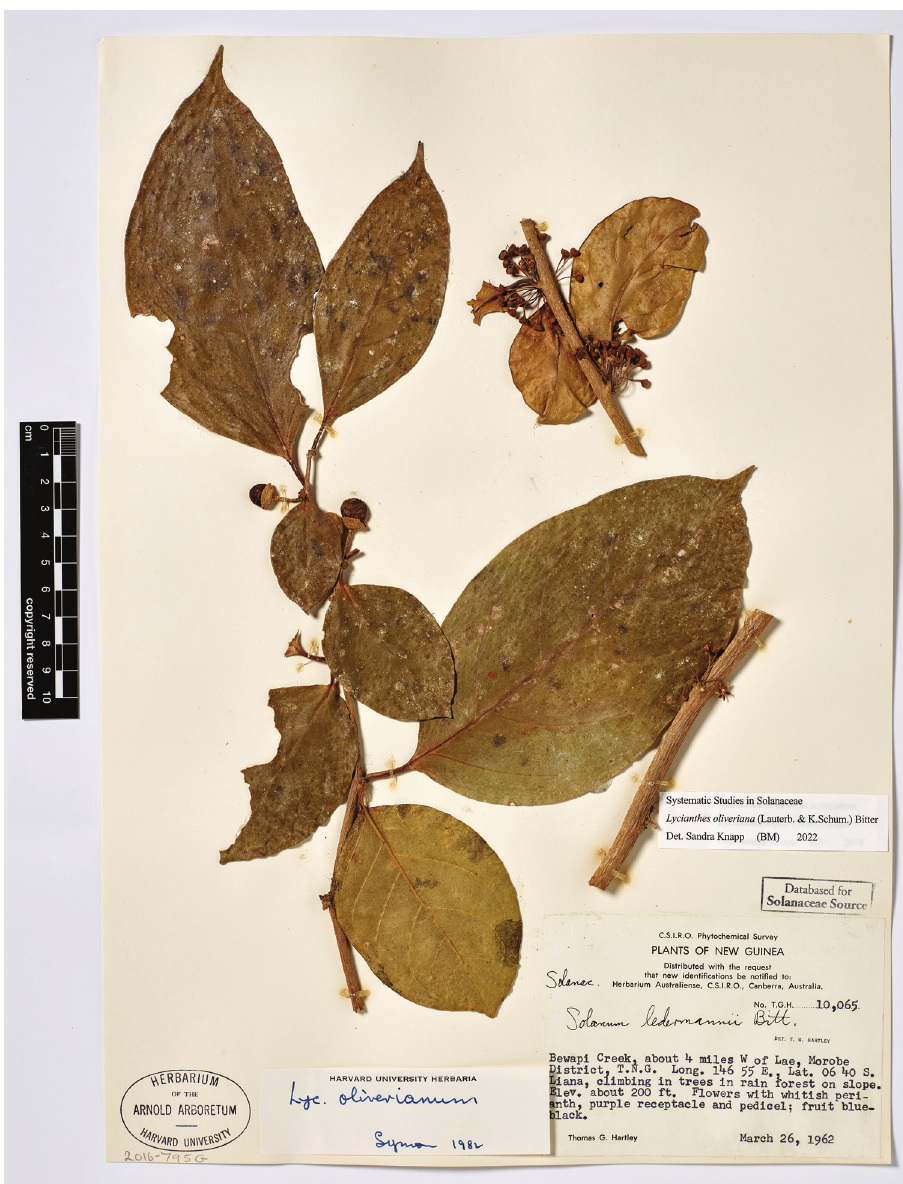
Figure 38. Lycianthes oliveriana herbarium specimen. Papua New Guinea. Morobe: Hartley 10065 (A). Courtesy of the Herbarium of the Arnold Arboretum of Harvard University, reproduced with